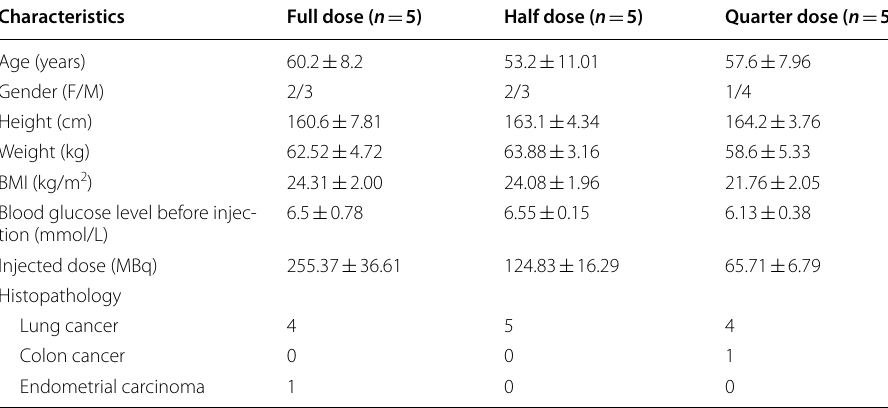
Table 1 Clinical characteristics of the enrolled oncological patients